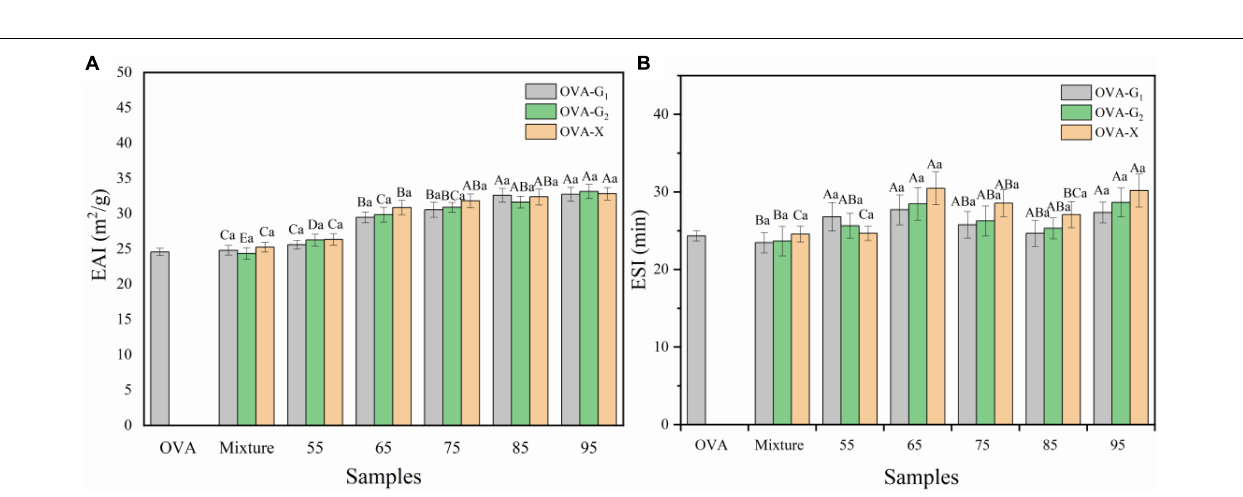
Frontiers in Nutrition |